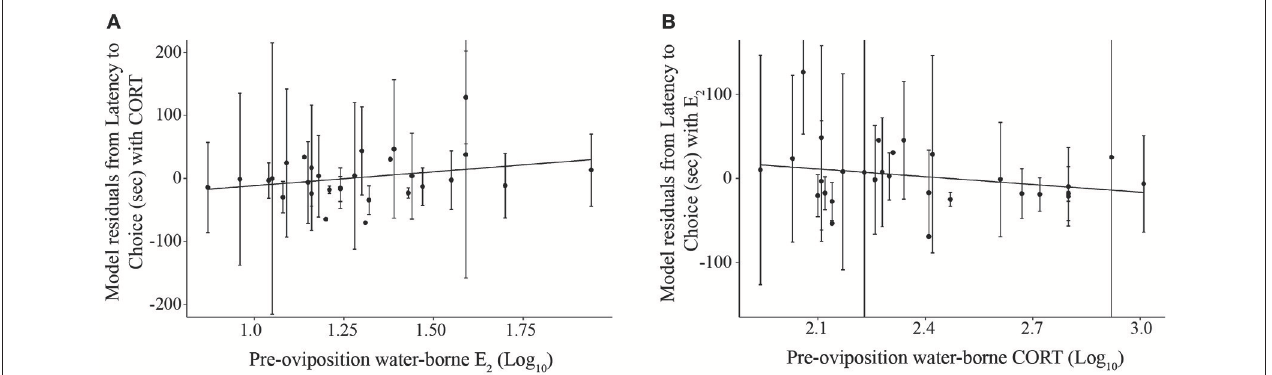
FIGURE 4 | Scatterplots depicting the relationships between (A) pre-oviposition water-borne estradiol (log 10 transformed) and mean choice latency, and (B) pre-oviposition water-borne corticosterone (log 10 transformed) and mean choice latency. The y-axis represents the residuals of the linear mixed effects model for latency to choice and the other hormone as the only fixed effect, and subject as a random effect. Solid lines depict significant relationships ( p < 0.05). Error bars depict standard deviations.